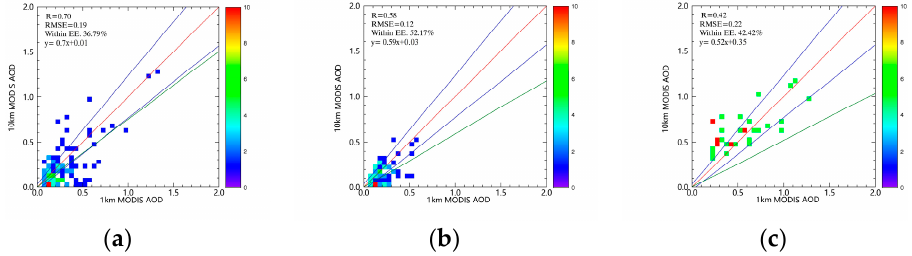
Figure 8. Results of 10 km, 3 km and 1 km MODIS AOD pretreatment in Beijing on October 18, 2020: ( a ) is 10 km AOD result, ( b ) is 3 km AOD result, ( c ) is 1 km AOD result.